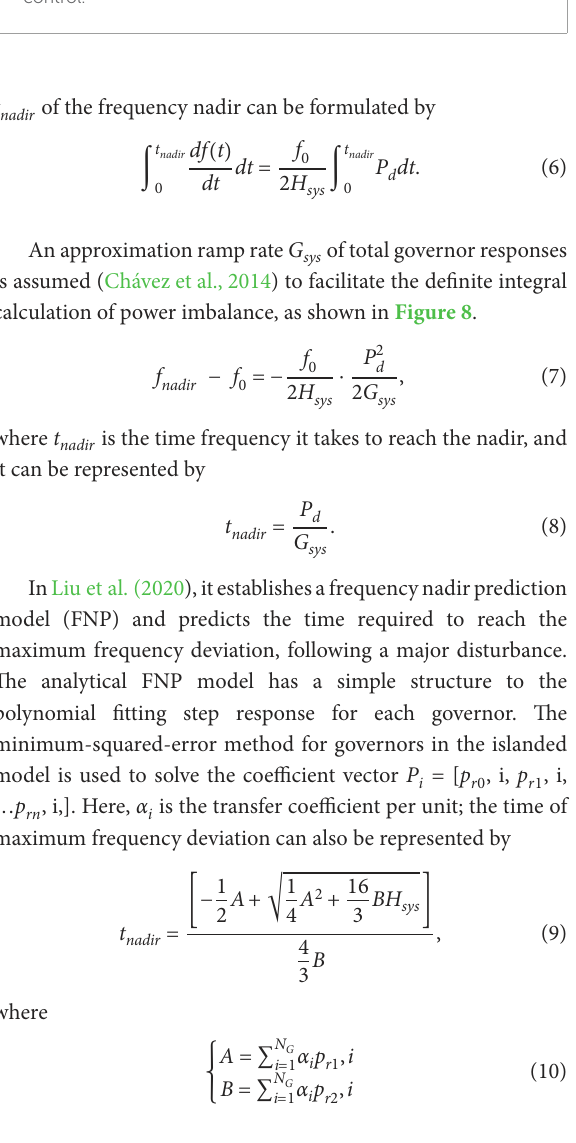
FIGURE 8 Relationship of the frequency nadir and drop power in primary